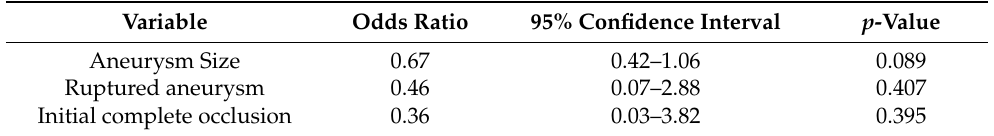
Table 4. Multivariate analysis of variables independently associated with post-procedural aneurysm contrast